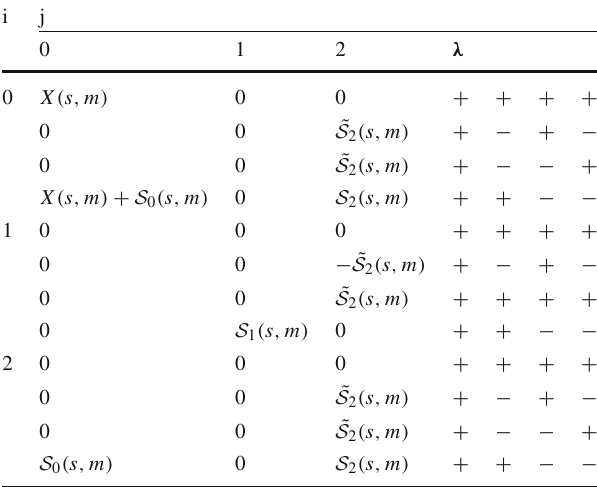
Table 4 Coefficients c of the isospin spin amplitudes calculated with Eq. (14) for the isoscalar scalar resonance L σ W depending on the helic- ity of the incoming and outgoing particles. The isospin spin amplitudes are given by A ij ( s ; λ ) = cg 4 s